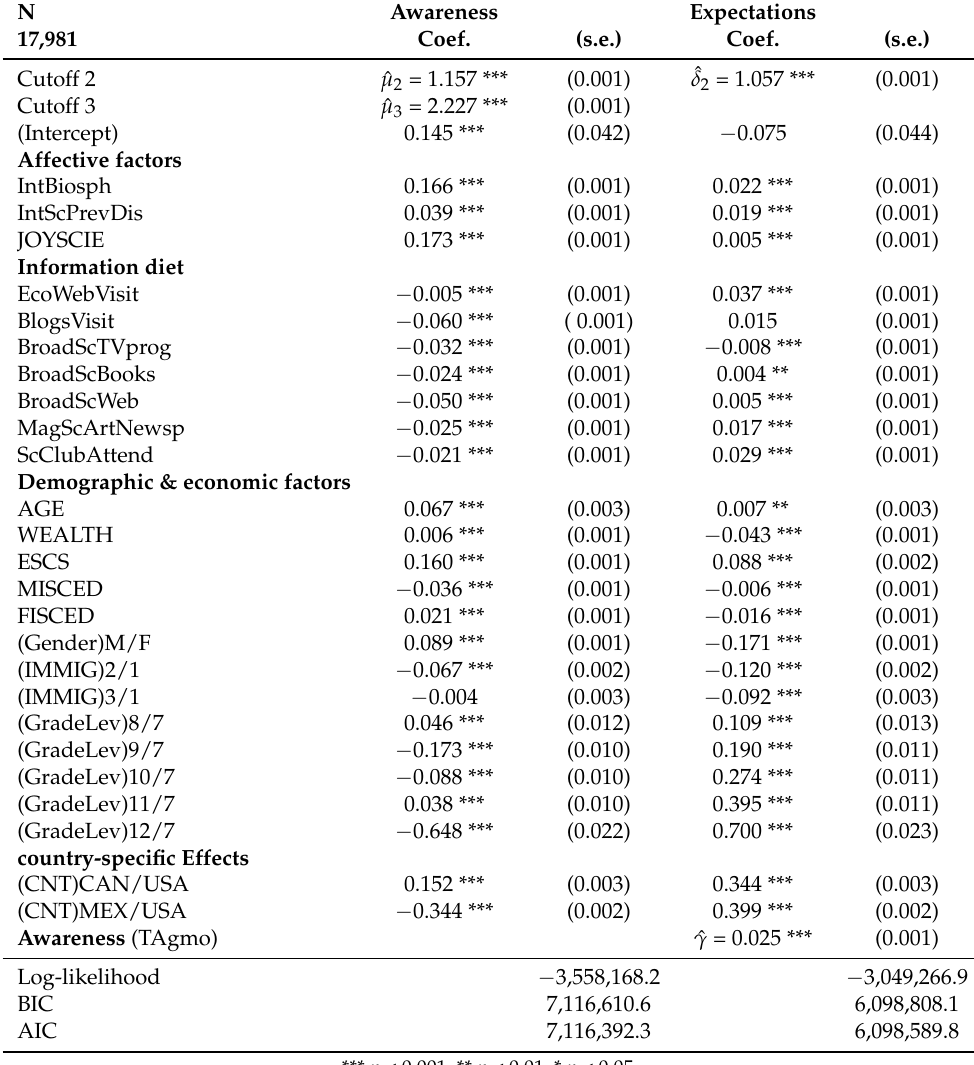
Table A3. MLE Results for Youth’s GMO awareness and Expectations within NAFTA.